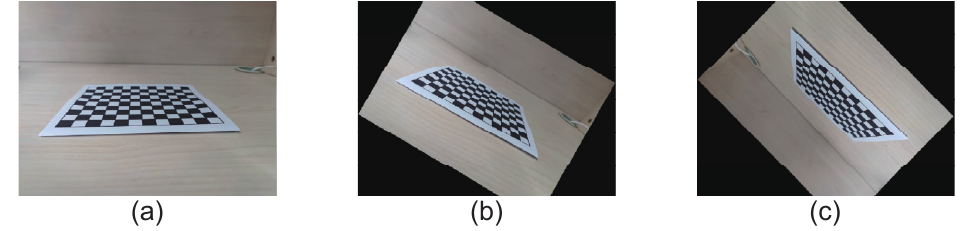
Figure 14. Rotation of the image. ( a ) Is the original image, ( b ) is the image rotated by 30° and ( c ) is the image rotated by −